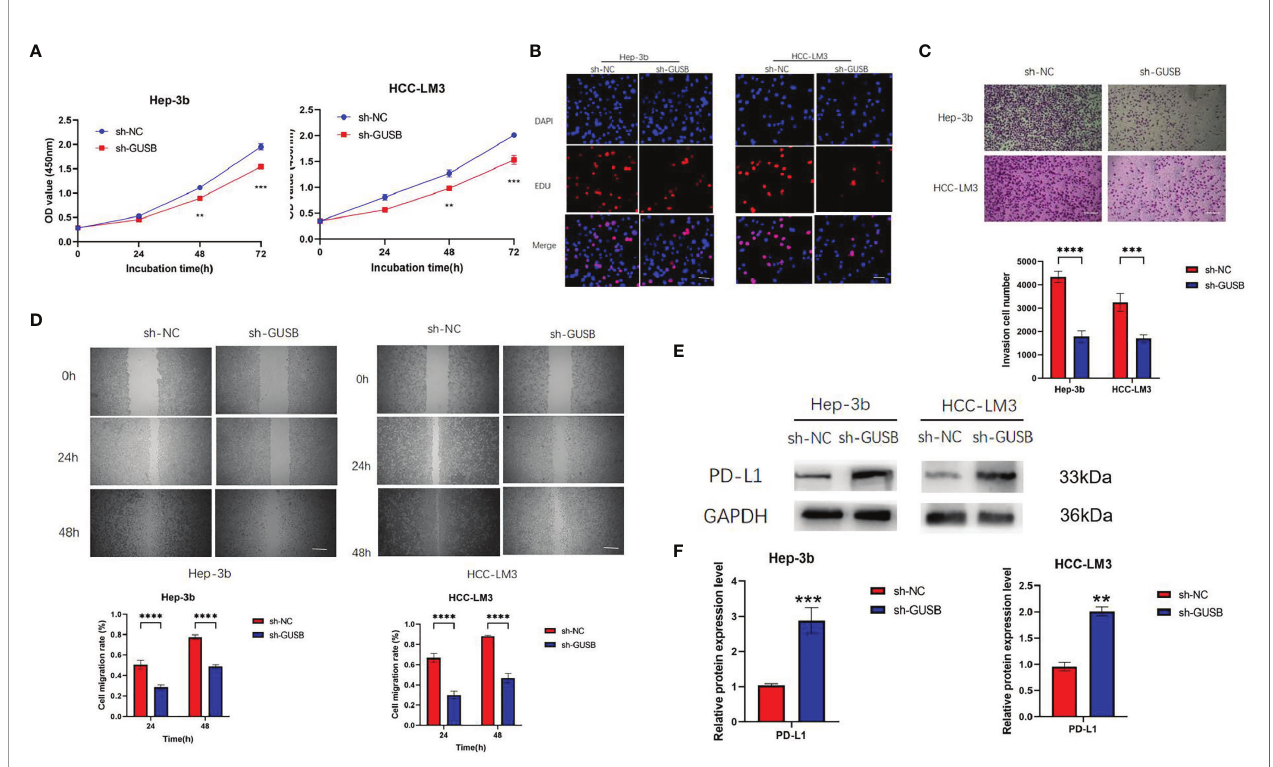
FIGURE 3 | Knocked down of GUSB inhibited the proliferation, invasion and migration of human HCC cells and up-regulated PD-L1 expression. (A) The growth curves of cells were plotted after transfection with sh-NC/sh-GUSB based on CCK-8 assay. (B) EdU assay was performed to assess cell proliferation of HCC cells transfected with sh-NC/sh-GUSB. Scar bar, 50 um. (C) Transwell invasion assay was performed to assess invasion of HCC cells transfected with sh-NC/sh-GUSB. Scar bar, 100 um. (D) Scratch assay was performed to assess the migration of HCC cells transfected with sh-NC/sh-GUSB. Scar bar, 250 um. (E, F) The protein expression of PD-L1 in HCC cells with GUSB knockdown. Panel (E) represents the variation of protein bands, and Panel (F) illustrates the protein gray value analysis. Each experiment was repeated three times. ** P < 0.01; *** P < 0.001; **** P <